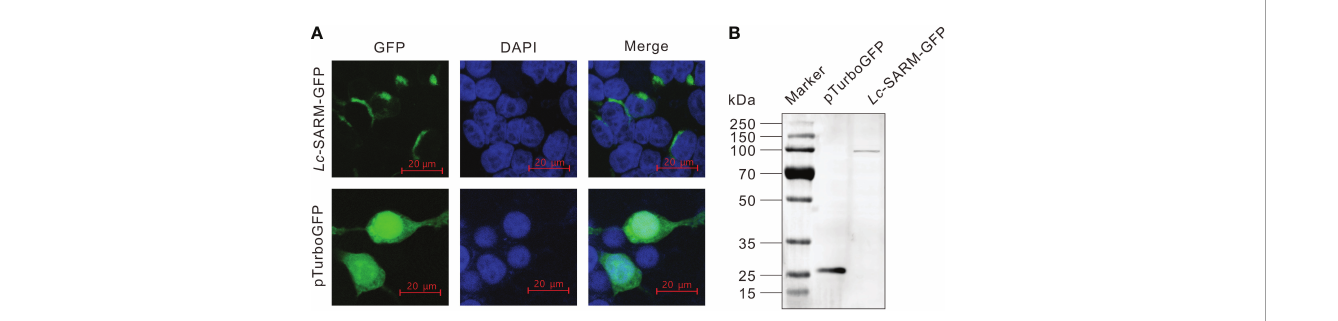
FIGURE 3 Subcellular localization of Lc- SARM. (A) HEK 293T cells were transfected with pTurbo-SARM-GFP and pTurboGFP-N (vector control), respectively. At 24 hpt, the cells were stained with DAPI and then detected and photographed under a confocal microscope. (B) The con fi rmation of the expression of Lc - SARM-GFP and pTurboGFP fusion proteins was conducted by Western blotting analysis using the Anti-TurboGFP